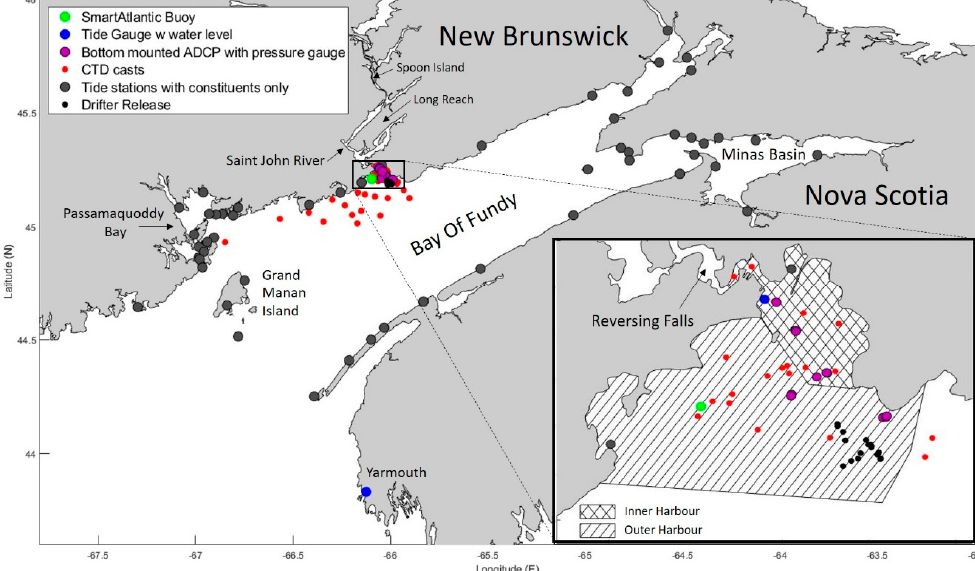
Figure 1. Map of the study area including the locations of the ocean observations, and the boundaries of the inner harbour and outer harbour.